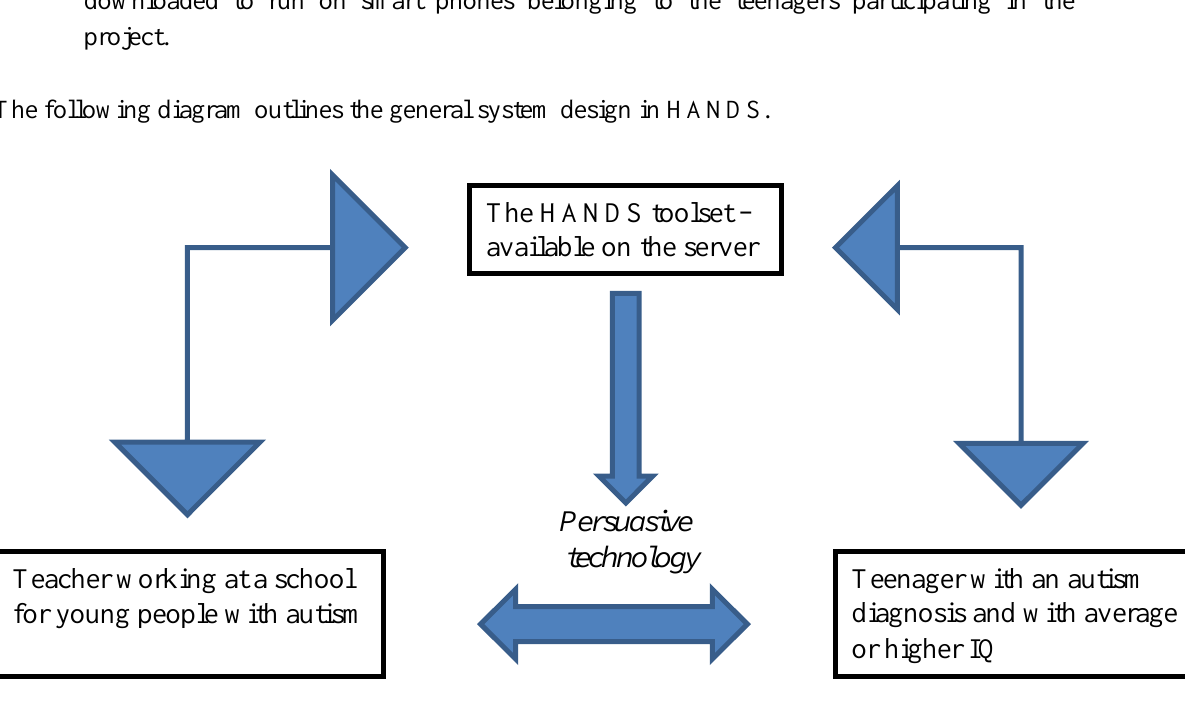
Figure 1 . The general HANDS system